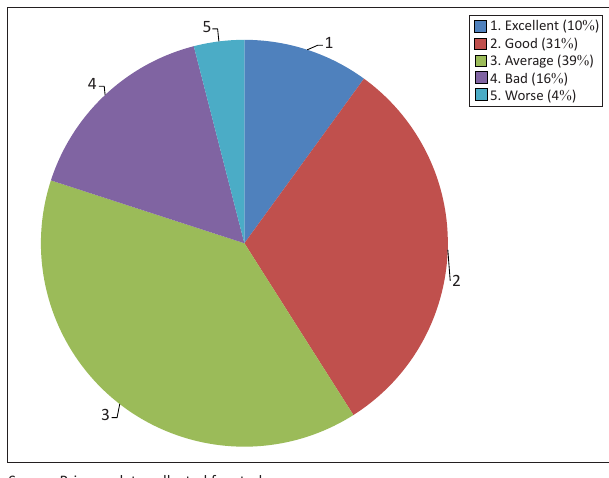
FIGURE 13: Self-rating on ability to respond to